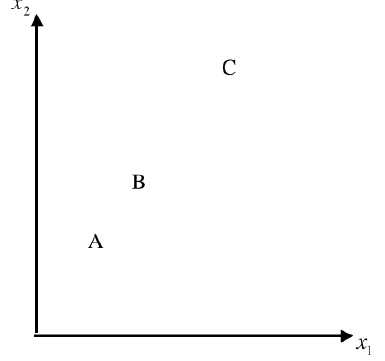
Figure 22. A and B are more similar than A and C.